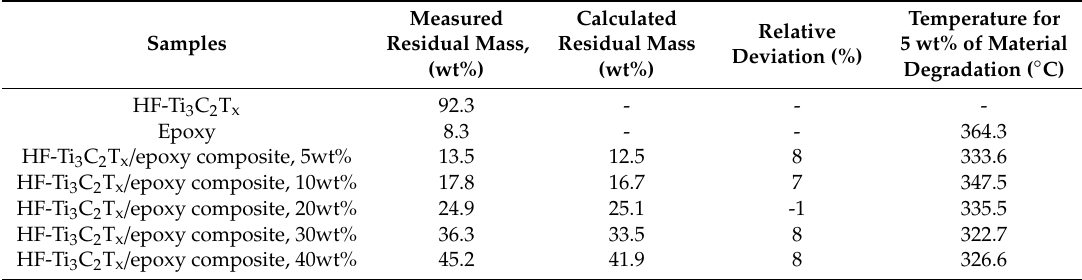
Table 1. Thermogravimetric data of HF-Ti 3 C 2 T x , epoxy and their